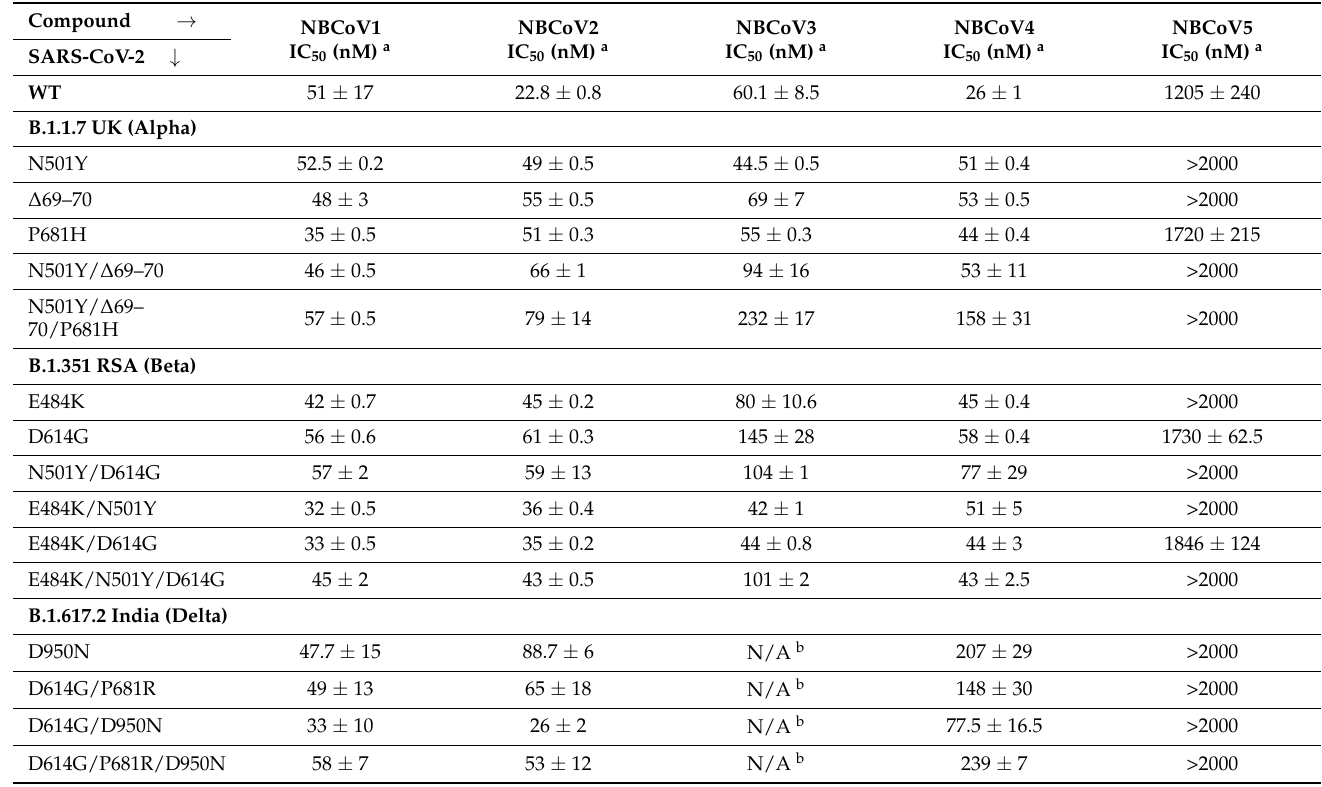
Table 6. Antiviral activity of the NBCoV small molecules against NL4-3 ∆